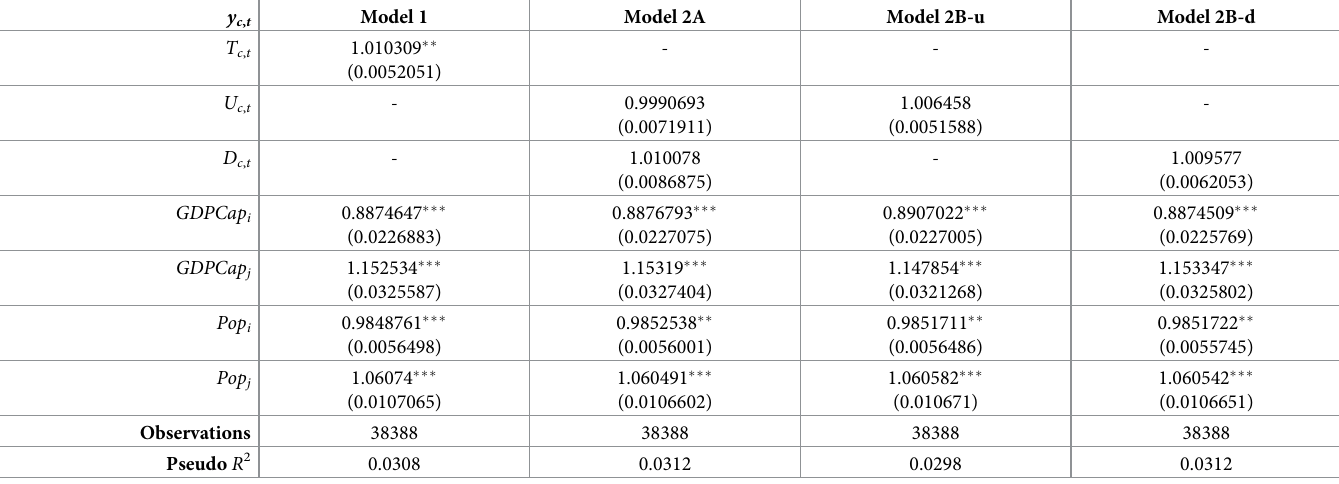
Table 5. Results of conditional logit